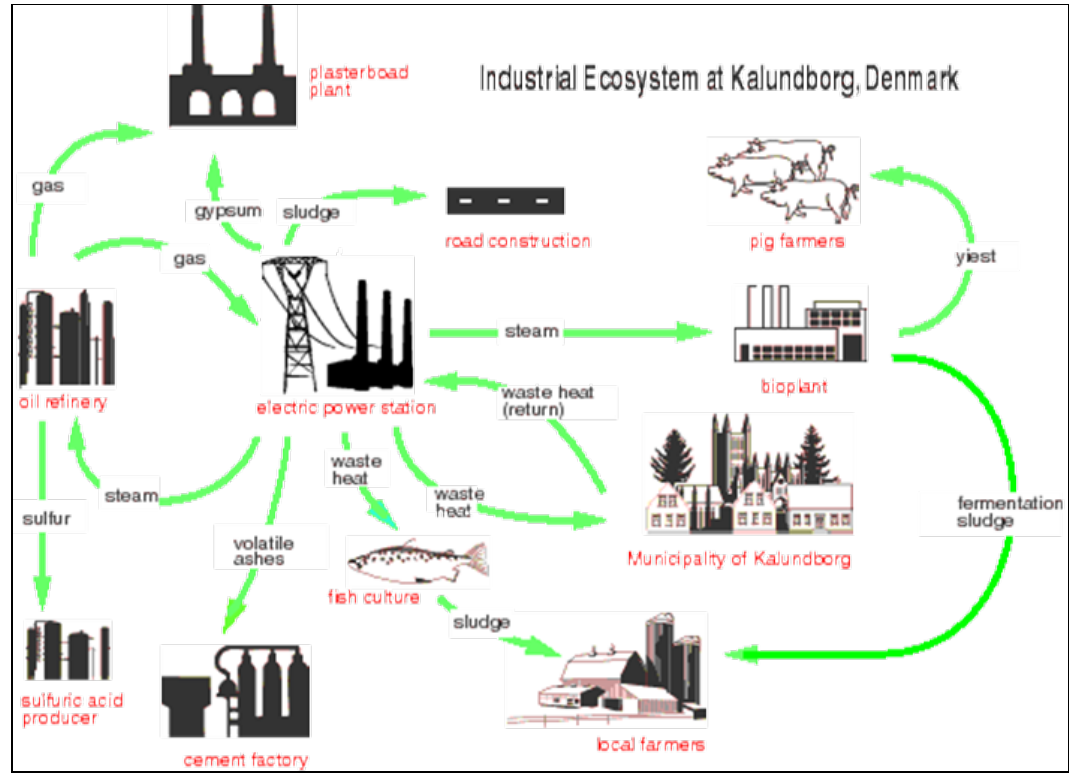
Figure 2. The several components of the industrial (eco) system at Kalundborg, Denmark and its interrelationships, including the flows of energy and materials between the several players